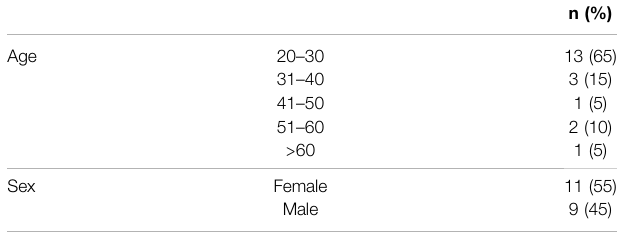
TABLE 2 | Study 2 participant demographics (N = 20).